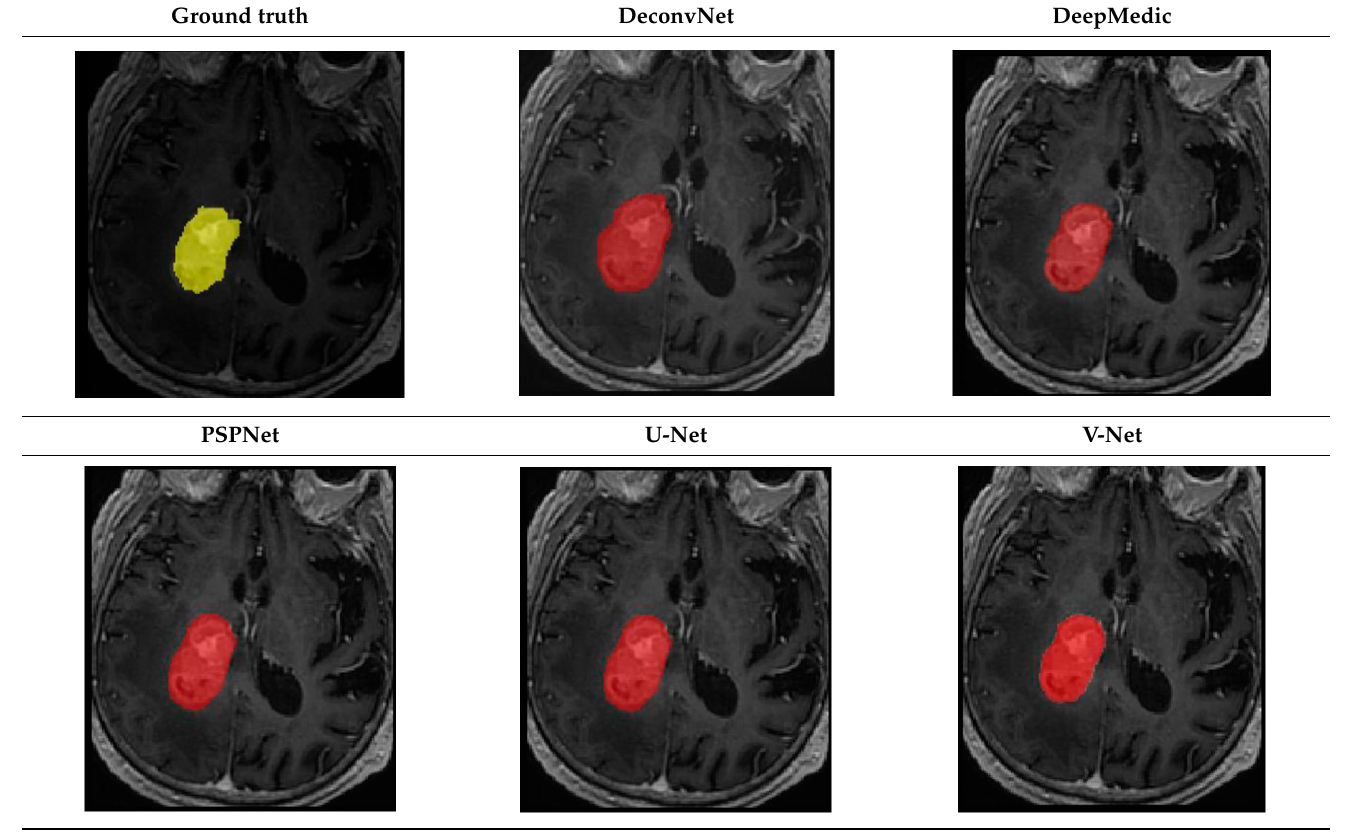
Table 4. Predictions with high dice scores.